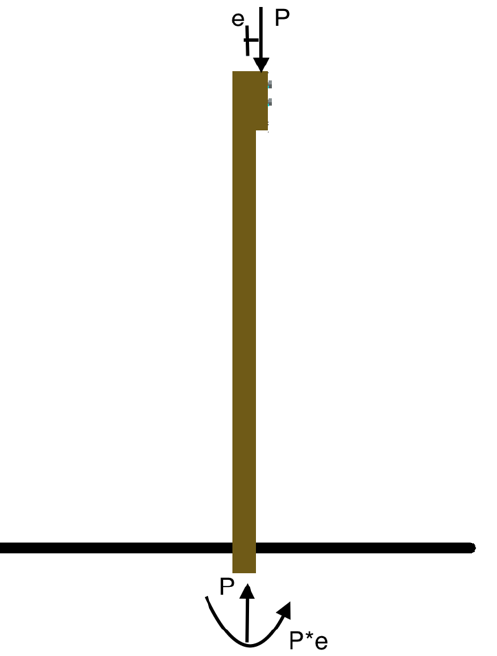
Figure A5. Single-span post free-body diagram with eccentric loading.